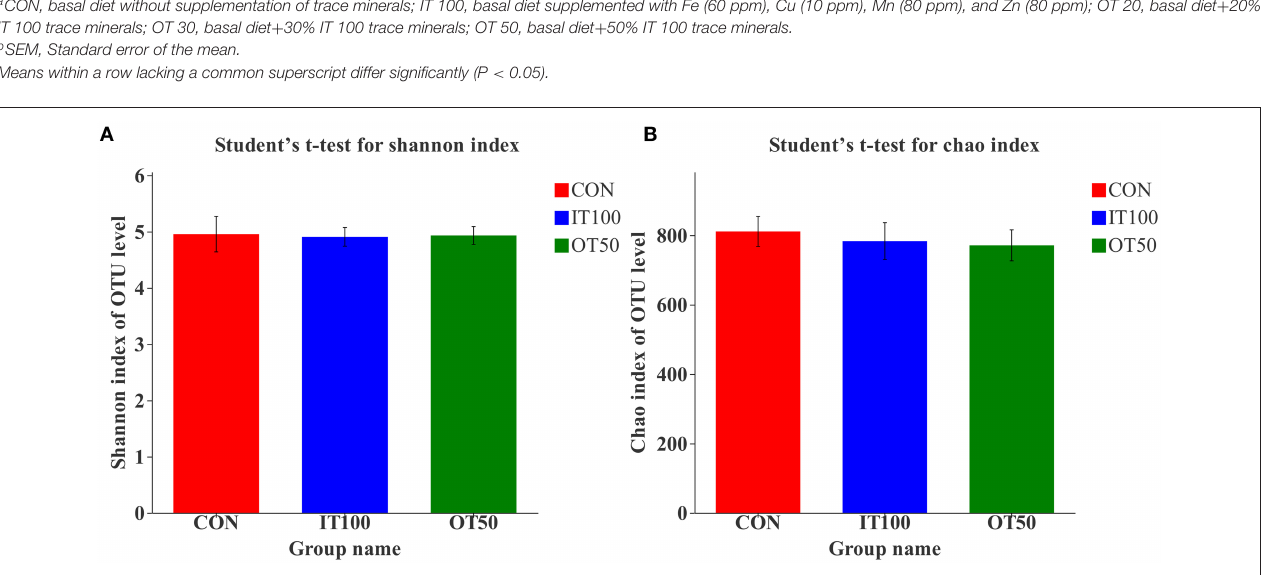
FIGURE 1 | Effects of inorganic and low level of organic trace minerals on the α -diversity including Shannon index (A) and Chao index (B) of caecal microbiota at the eighth week of the experiment with hen layer at the age of 67 weeks ( n = 6). CON: control treatment, basal diet without supplementation of trace minerals; IT 100: basal diet supplemented with Fe (60 ppm), Cu (10 ppm), Mn (80 ppm), and Zn (80 ppm) as sulfates; OT 50: basal diet + 50% IT 100 trance minerals as amino acid